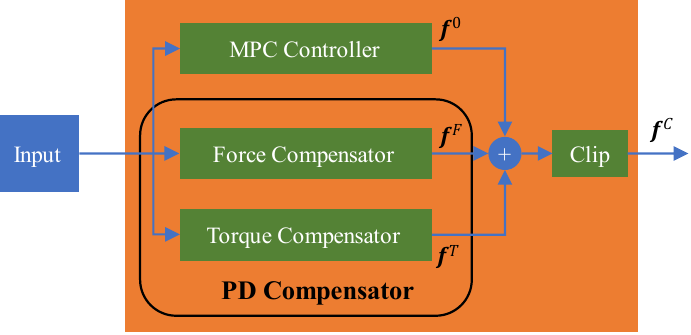
Figure 3. PDMPC architecture.